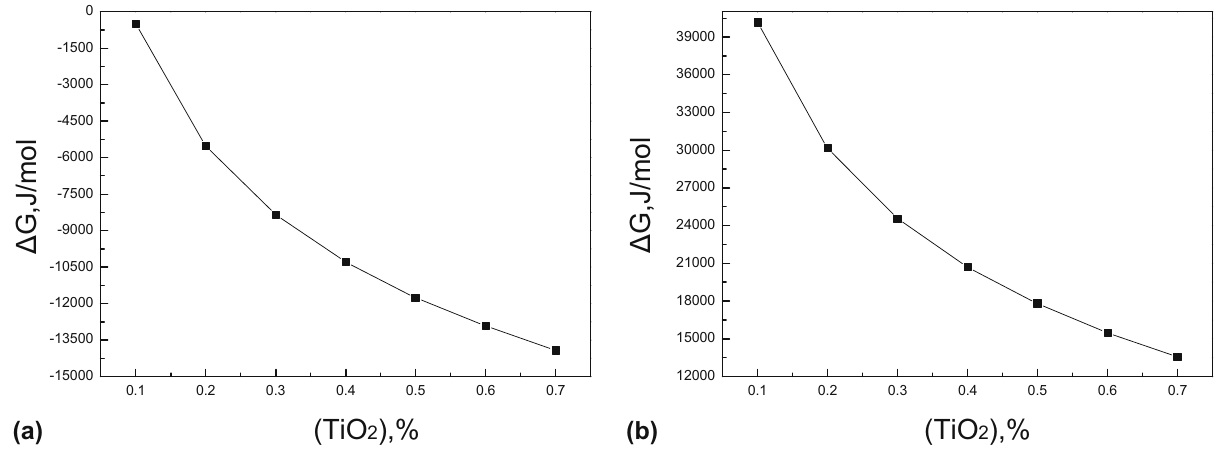
Figure 2: Variation in Gibbs free energy with di ff erent di ff usion deoxidizer. ( a ) Al as di ff usion deoxidizer; ( b ) Si as di ff usion deoxidizer.